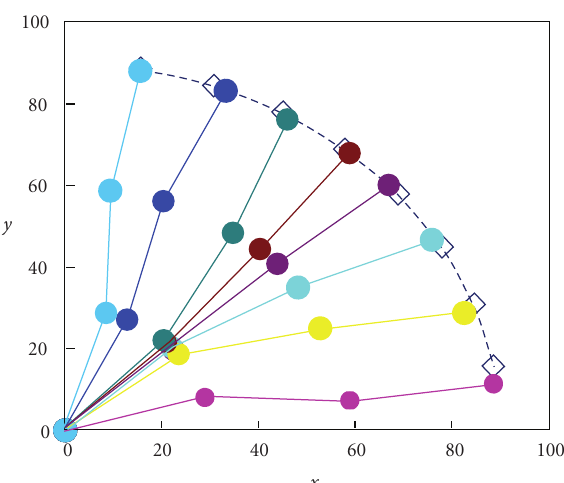
Figure 7: Graph showing the coordinates of robot arm whose joint angles are estimated by network inversion for well-posed problem.